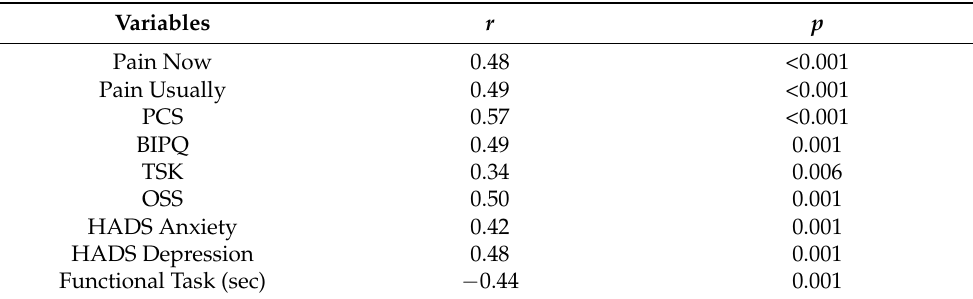
Table 2. Correlations between CS symptoms and psychosocial, emotional, and functional parameters ( N = 64). r p Pain Now 0.48 <0.001 0.49 <0.001 0.57 <0.001